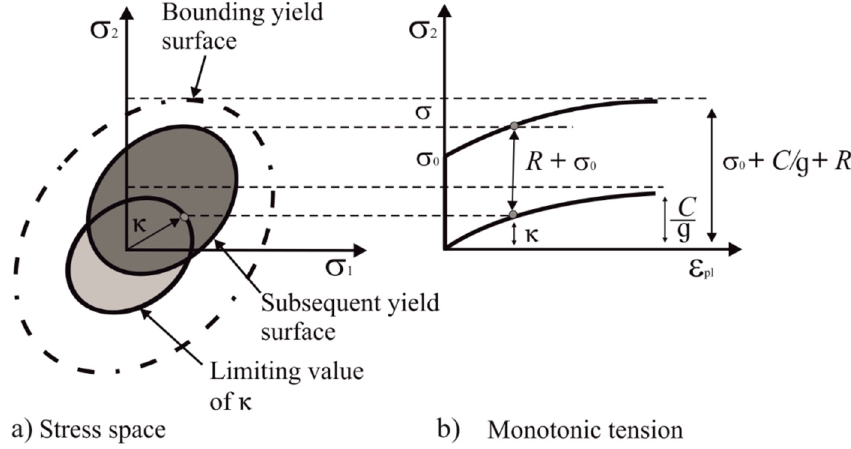
Figure 6. Graphical representation of the combined hardening evolution in the ( a ) stress space and ( b ) under monotonic tension after [42].